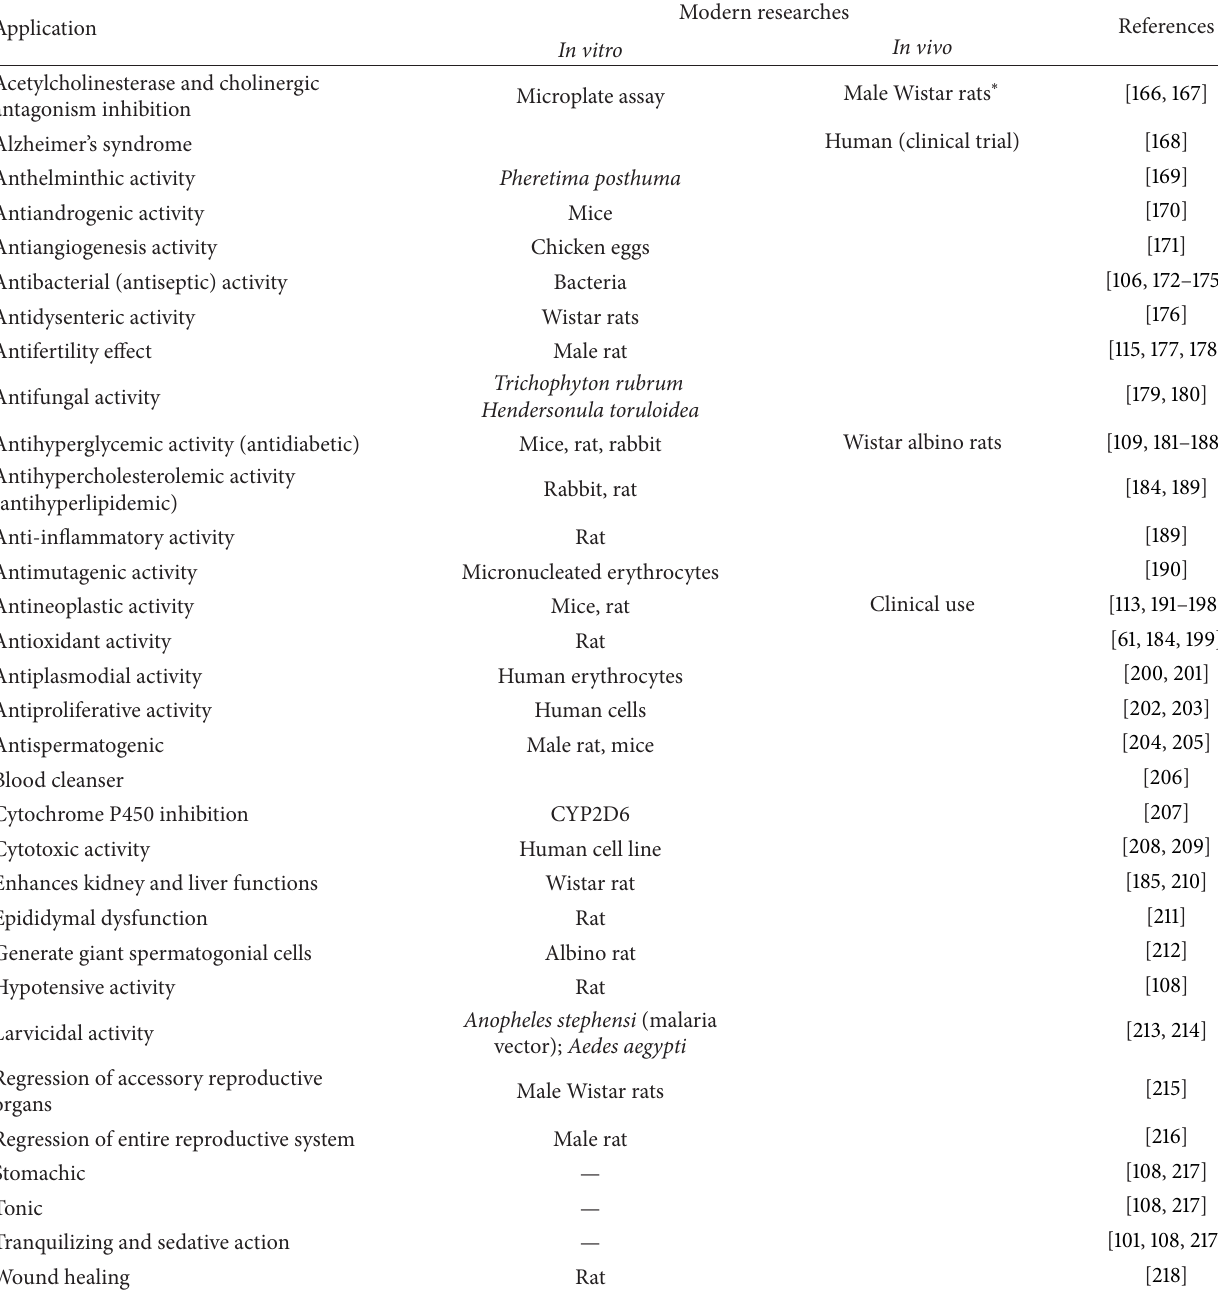
Table 5: List of the most important studies on the medicinal effects of Catharanthus roseus